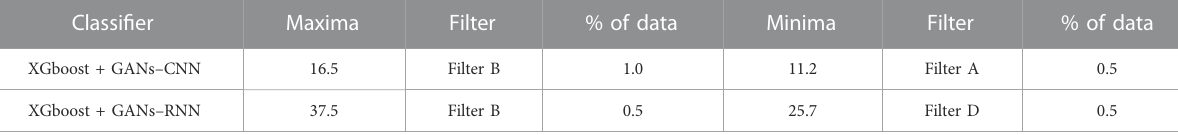
TABLE 9 Enrichment Ratios of OPRD1 on the dataset consisting of features as shown in Table 8 with training size of 30%. Classi fi er